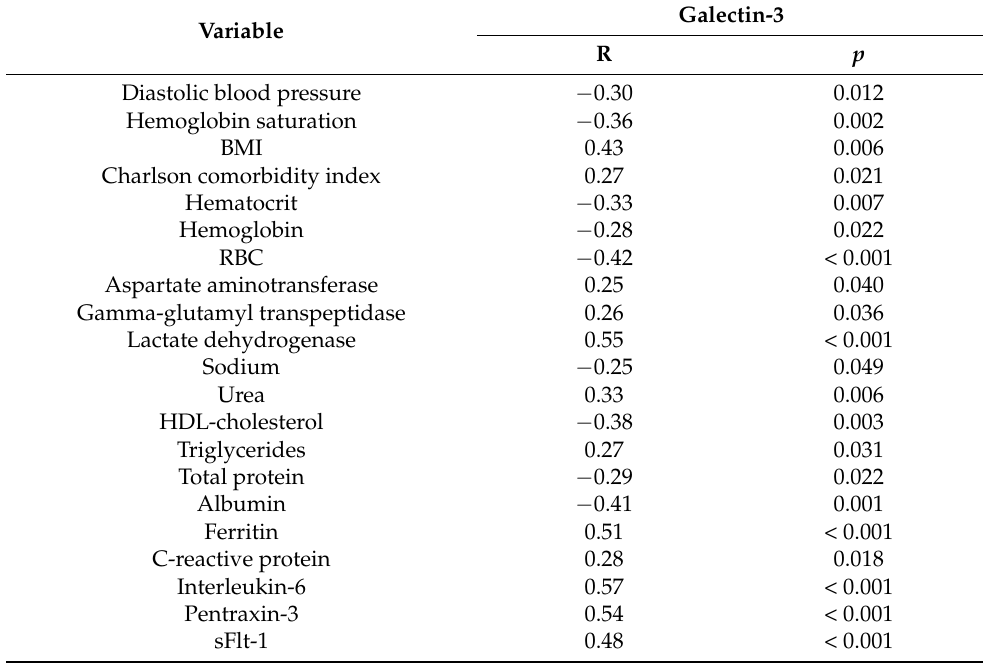
Table 5. Statistically significant correlations between galectin-3 and the selected variables. We report the Spearman rank correlation coefficients (R) and p